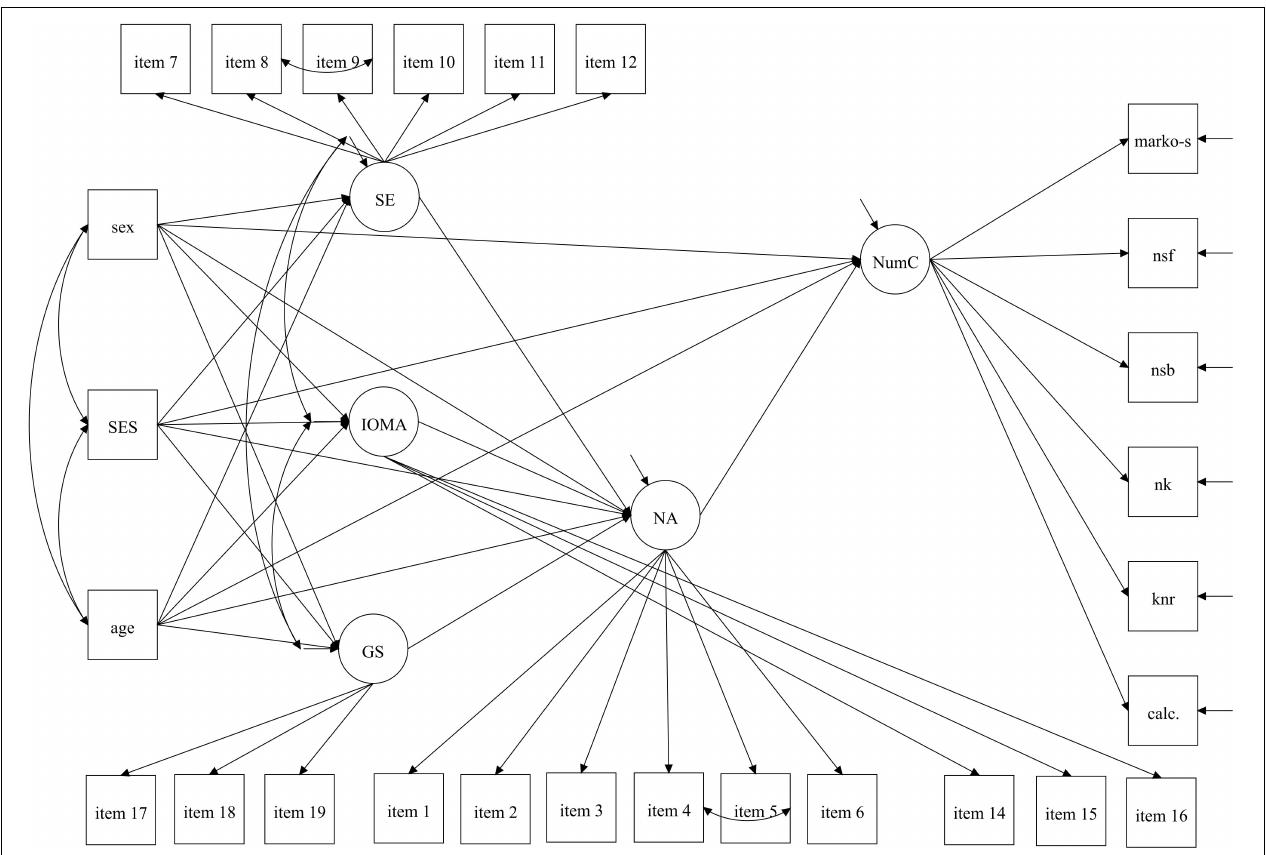
FIGURE 1 | Modified theoretical Model of the associations between parents’ beliefs, their numeracy activities and children’s numeracy competencies. NumC, children’s numeracy competencies; NA, numeracy activities at home; GS, gender stereotypes; SE, self-efficacy; IOMA, importance of mathematical activities at home. Sex, children’s sex; Age, children’s age in month. marko-s, Marko-S; nsf, number sequences forward; nsb, number sequences backward; nk, number knowledge; knr, knowledge of number representation; calc. calculation task. Item description of items 1–19 (see Supplementary Material